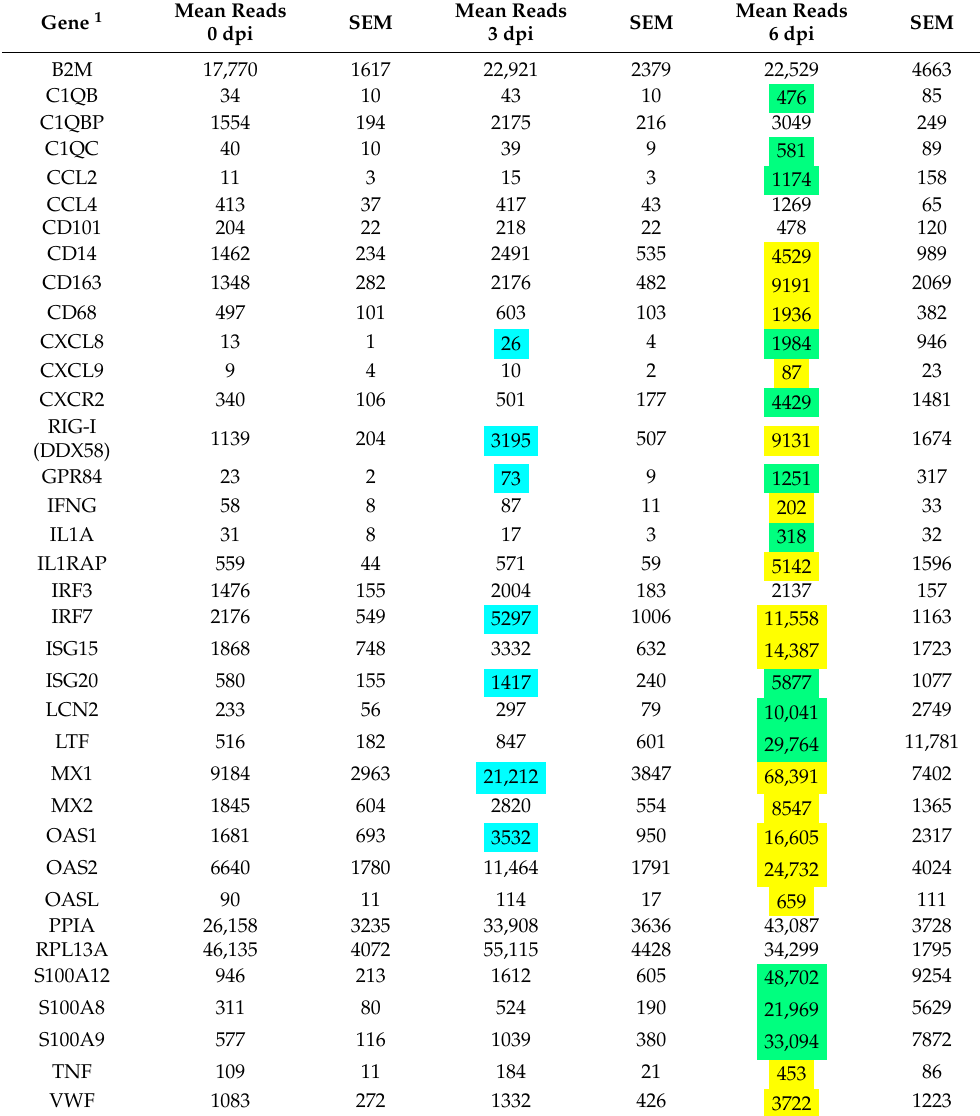
Table 1. The mean values of normalised reads (plus SEM) for selected genes in the 4 pigs inoculated with ASFV in PBMCs collected at 0, 3 and 6 dpi as determined by RNAseq. Genes that were increased in expression at 6 dpi by >3-fold or >10-fold compared to 0 dpi are highlighted in yellow and green, respectively. Genes increased by ≥ 2-fold at 3 dpi are highlighted in blue; note that these genes are each involved in the generation of an anti-virus